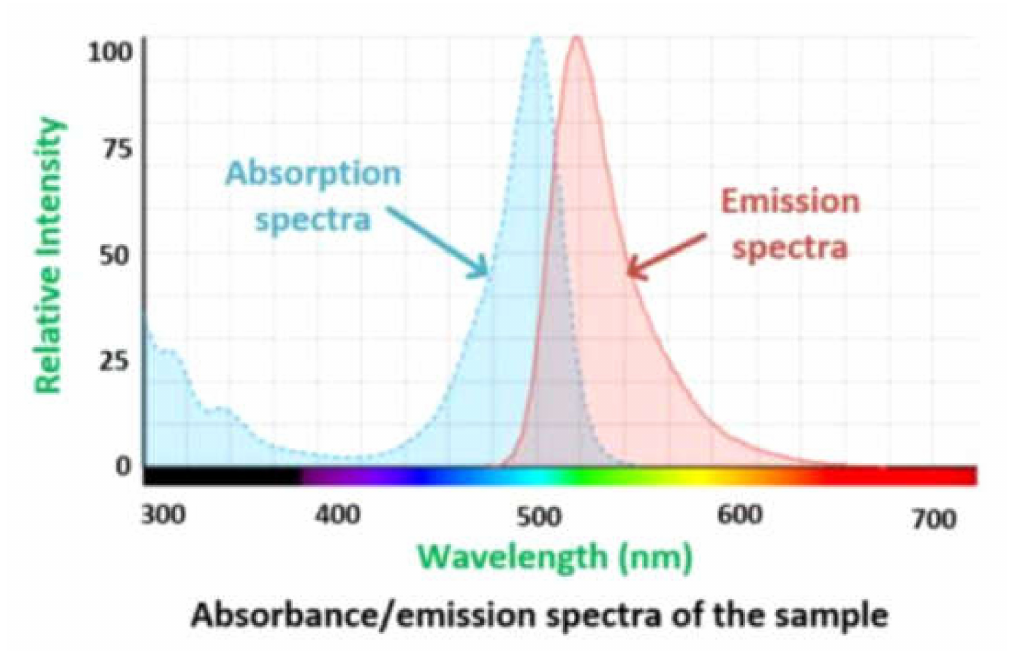
Figure 5. Absorption / emission spectra of the sample adapted from